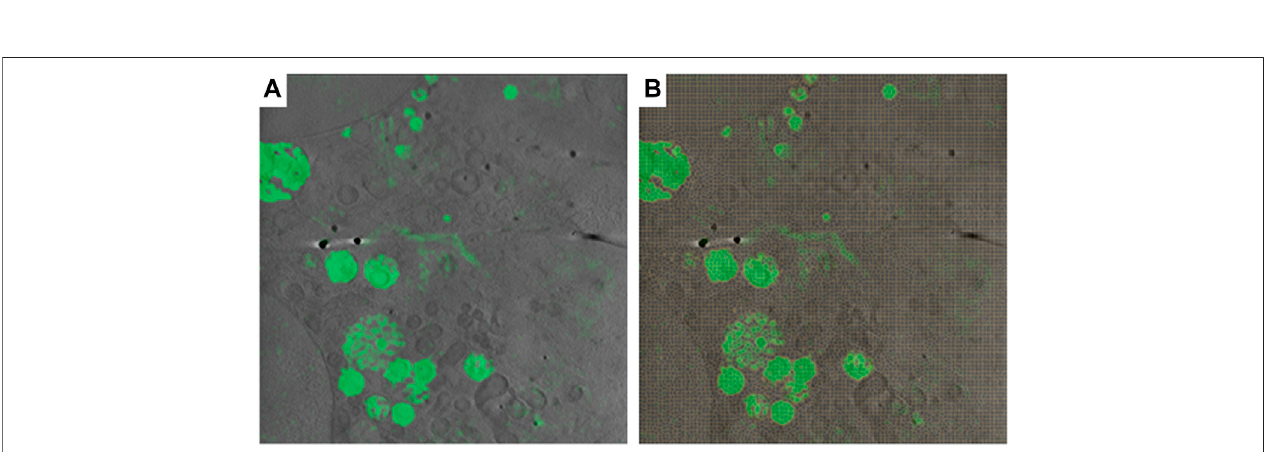
FIGURE 8 | 3D CryoSXT with correlated 3D cryoSIM in SuRVoS2. (A) Multimodal imaging can be displayed together as individual layers with control over opacity and color. (B) SuRVoS2 speci fi c functionality, such as supervoxels (shown in yellow) can be calculated using one of the datasets for use during segmentation or annotation of the